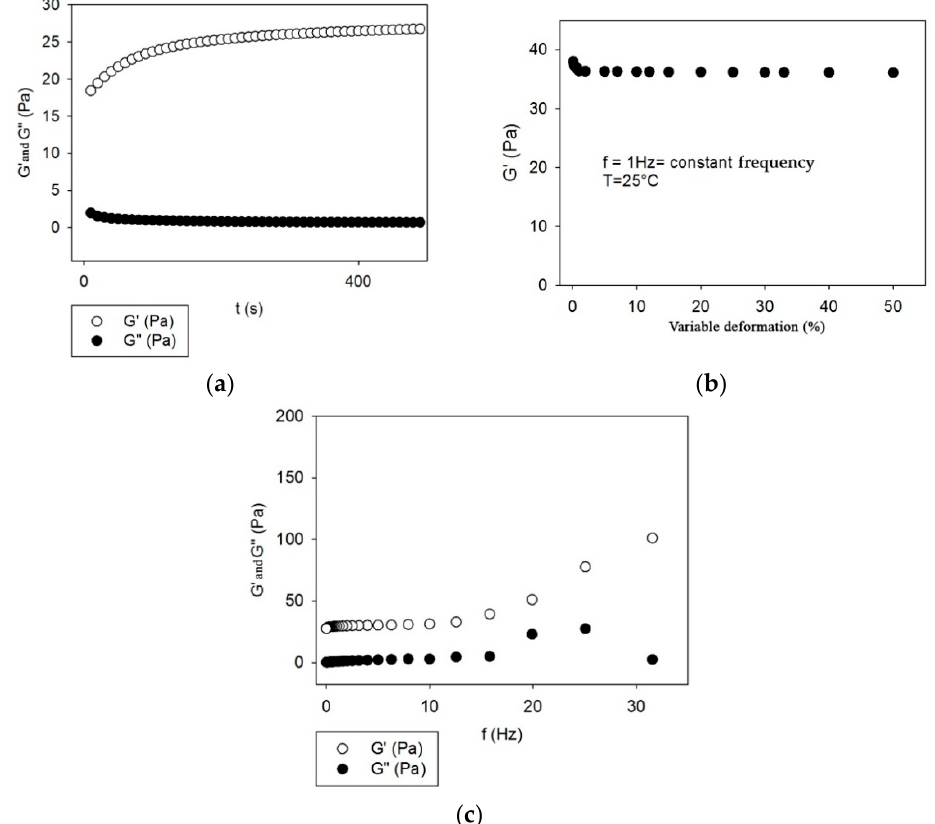
Figure 1. Rheological characterizations of Alg–Cat gels. ( a ) Gelation kinetics performed at 1 Hz and a constant strain of 1% displaying the time change in the storage G’ ( ) and loss G” ( ) moduli; ( b ) strain sweep experiment performed at a constant frequency of 1 Hz; ( c ) frequency sweep experiment performed at a constant strain of 1% displaying the change in the storage G’ ( moduli G” ( •